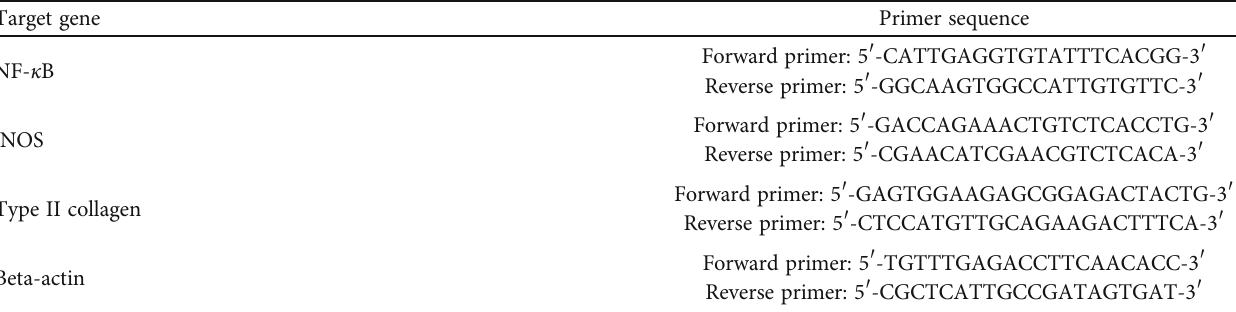
Table 1: Primer sequences used for real-time PCR.